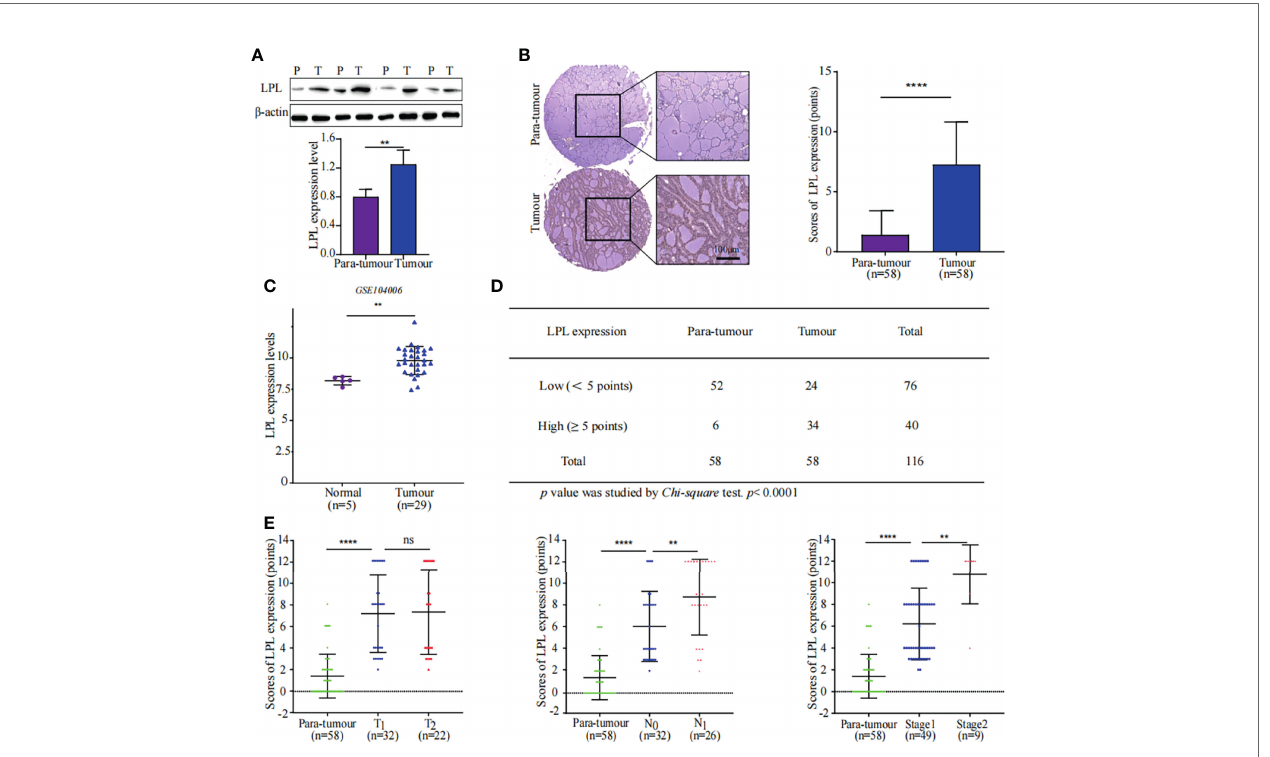
FIGURE 4 | High expression of LPL was associated with poor prognosis in PTC. (A) LPL expression in tissue samples was measured using western blotting (WB). Representative WB diagrams of LPL expression are shown in the top panel. The quanti fi cation data are shown in the lower panel, ** p < 0.01. The error bar indicates s.d., two-tailed unpaired t -test. P indicates para-tumour, T indicates tumour. (B) LPL expression and localisation were evaluated using tissue microarray. The left panel shows immunohistochemical staining for LPL (brown) with Mayer ’ s haematoxylin counterstain. Scale bar 100µm. Statistical data of LPL protein expression in 58 paired samples are shown in the right panel. **** p < 0.0001. Error bar indicates s.d. , two-tailed unpaired t-test. (C) Data of LPL mRNA levels were obtained from publically available dataset (GSE104006). ** p < 0.01. The error bar indicates s.d. , student t -test. (D) Statistical analysis of LPL expression in tissue microarray. Chi- square test was used to analyse signi fi cant differences, **** p < 0.0001. (E) Correlation between LPL expression and stages of thyroid cancer. The graph in the left panel shows that LPL expression was positively correlated with the T stage in PTC. The graph in the middle panel shows that LPL expression was positively correlated with the N stage in PTC. The graph in the right panel shows that LPL expression was positively correlated with the TNM stage in PTC. **** p < 0.0001, ** p < 0.01; ns indicates: not statistically signi fi cant. All error bars indicate s.d ., two-tailed unpaired